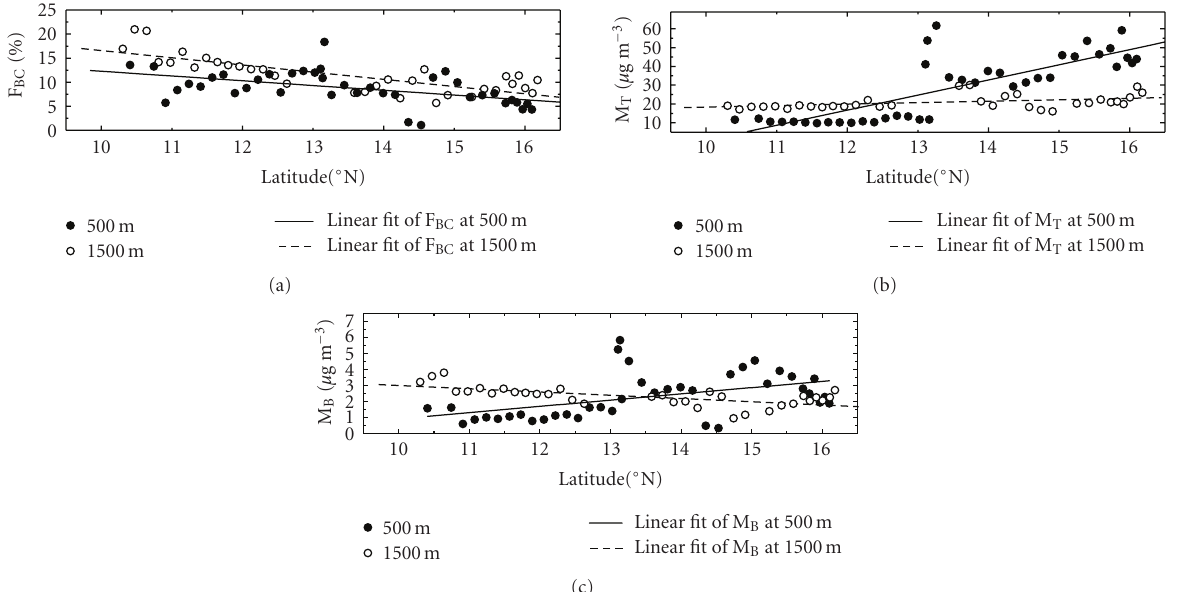
Figure 5: Latitudinal variation of M B , M T , and F BC at 500 m and